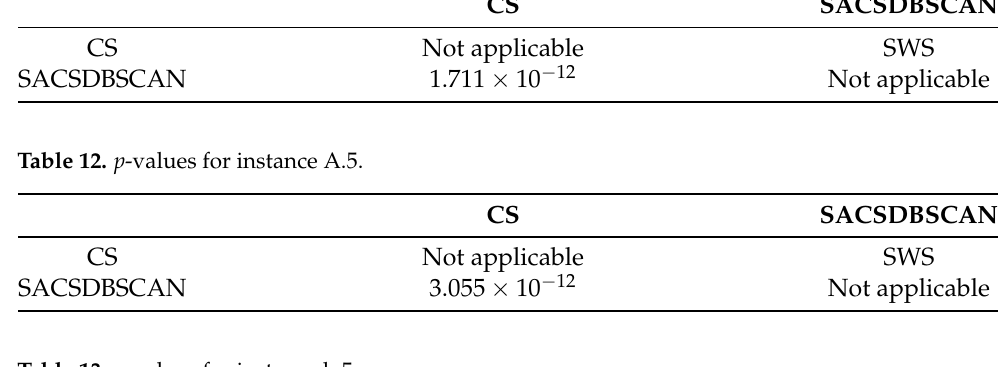
Table 13. p -values for instance